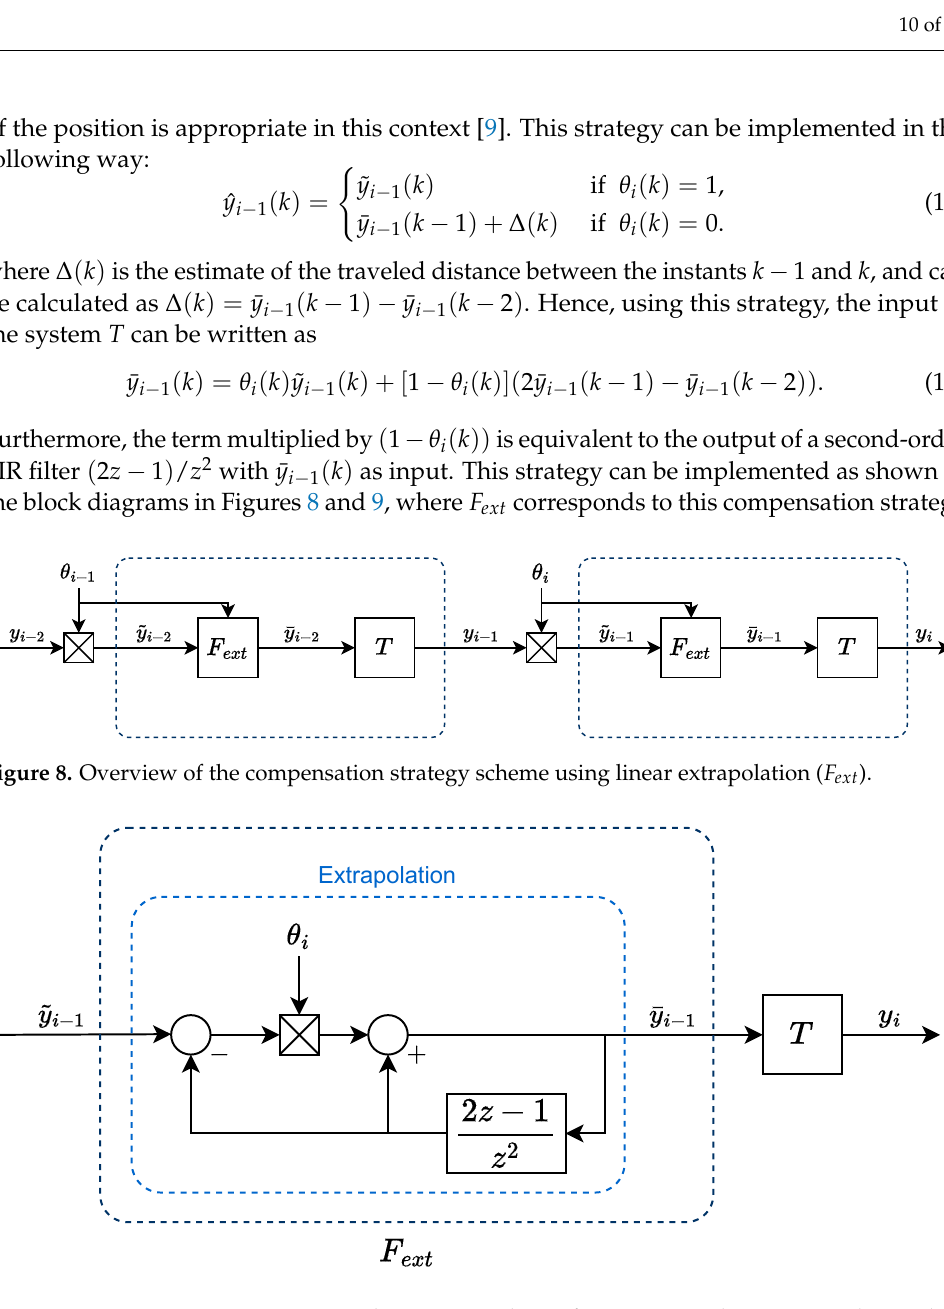
Figure 9. Compensation strategy using linear extrapolation for estimating the transmitted preceding vehicle’s output ˜ y i − 1